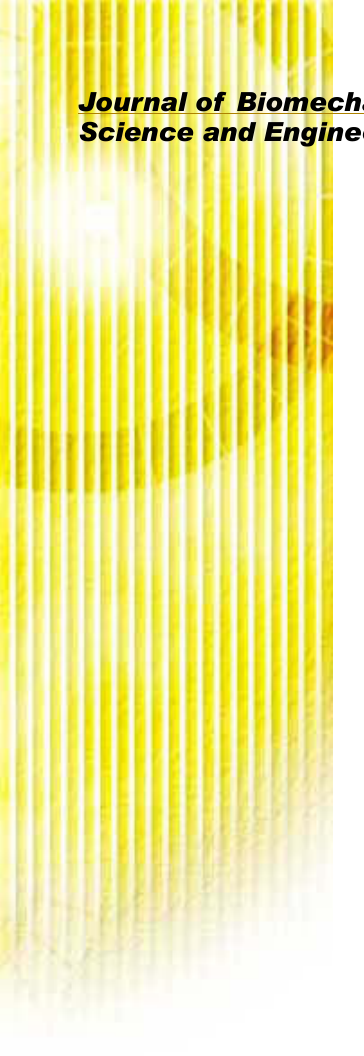
(a) Mean pressure P oav . (b) Amplitude of pulsation ∆ P o . Fig. 12 Comparison of numerical result with experimental